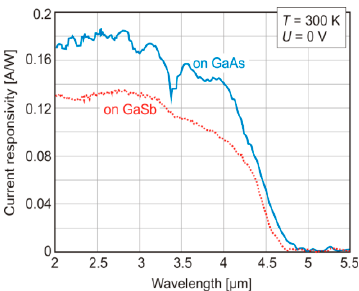
Figure 1. Spectral photoresponse for T2SLs based ICIPs grown on GaSb and GaAs